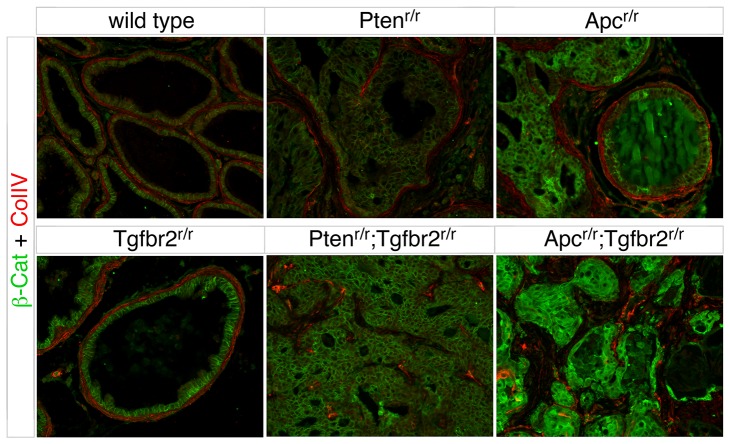
Basement membrane breakdown in double null prostates.Indirect immunofluorescence is shown for β-catenin (green) and Collagen IV (red) on sections of prostate from mice of the indicated genotypes. Wild type: 21 weeks, Tgfbr2r/r: 44 weeks, Ptenr/r: 21 weeks, Ptenr/r;Tgfbr2r/r: 11 weeks, Apcr/r: 36 weeks, and Apcr/r;Tgfbr2r/r: 24 weeks old.